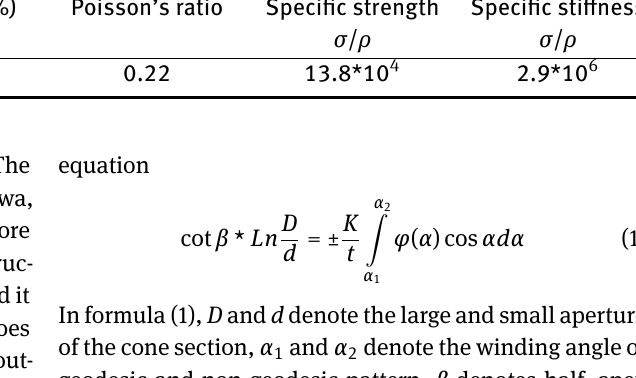
Filament winding path can be divided into geodesic winding and non-geodesic winding, the stable non- geodesic winding line of gasbag cone needs to meet the